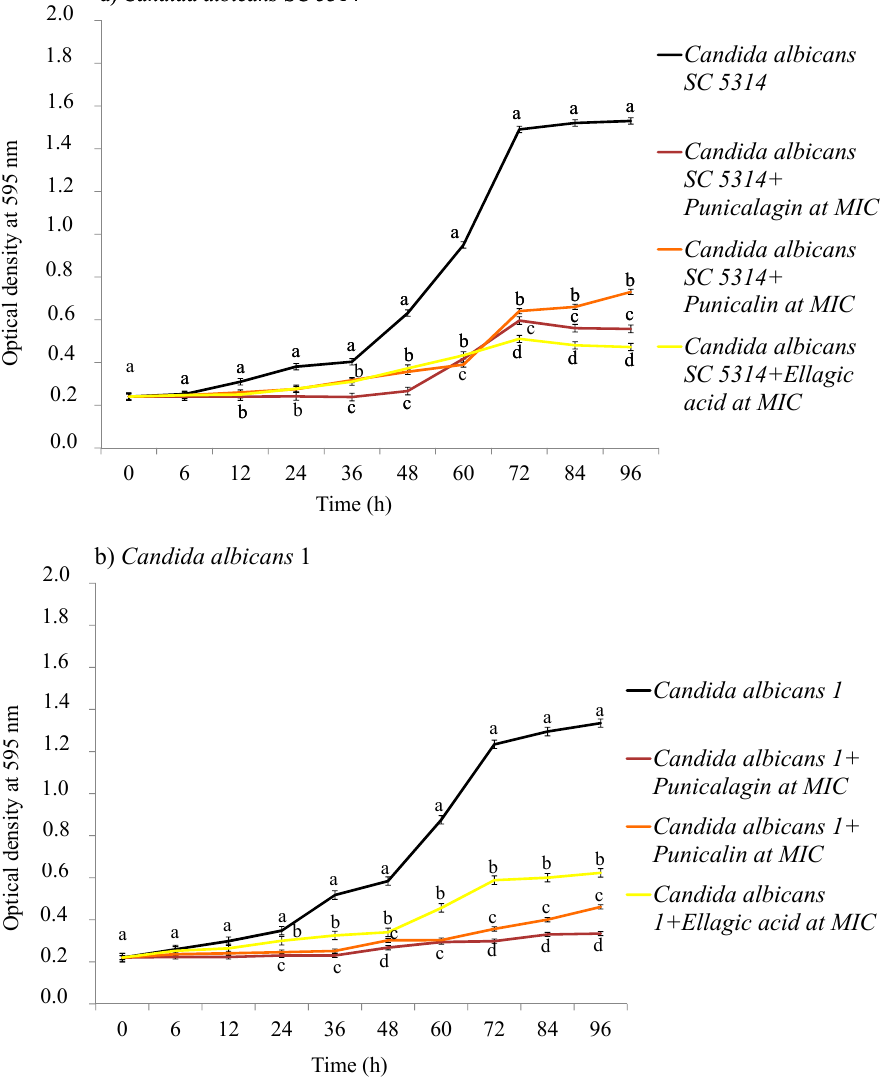
Figure 2. Time-kill curves of punicalagin, punicalin and ellagic acid against Candida albicans SC 5314 classified strain (panel ( a )) and the clinically isolated strain C. albicans 1 (panel ( b )). Results were expressed as mean ± SD of the three determinations. Different letters indicated statistical differences ( p ≤ 0.05) .